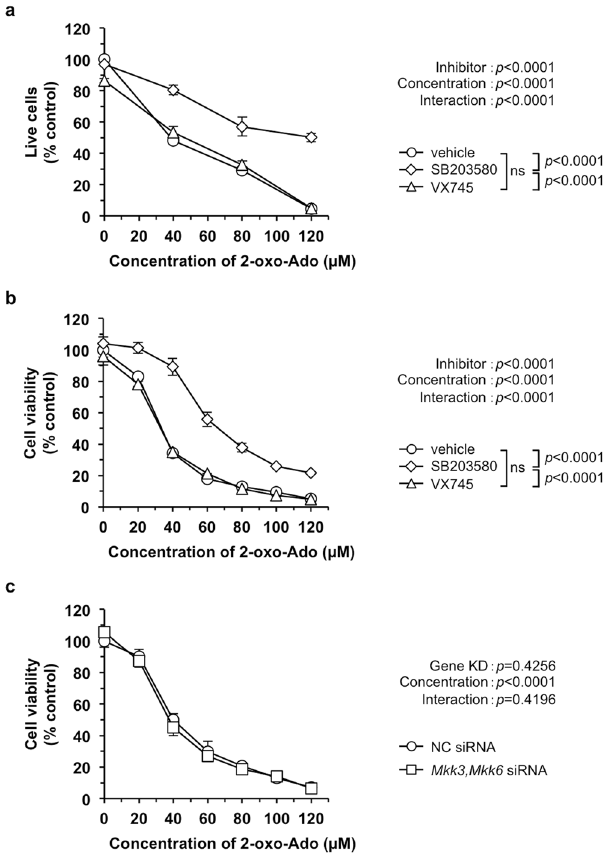
Figure 5. SB203580 blocks 2-oxo-Ado-induced cell death but not via inhibition of the p38 MAPK pathway. ( a , b ) The number of live T9 cells was determined by trypan blue exclusion ( a ), and cell viability of T9 cells was determined by WST-8 assays ( b ). Cells were incubated in the presence of various concentrations of 2-oxo-Ado with or without the indicated inhibitors for 24 h. SB203580 and VX745, 10 µ M. Vehicle control, 0.1% DMSO. Values (% control) of the number of live cells relative to that of the control in the absence of 2-oxo-Ado are shown as the mean ± SD of three experiments. ( c ) Cell viability of T9 cells was determined by WST-8 assays. Cells were treated with target siRNAs or NC siRNA as the control for 48 h and then incubated with various concentrations of 2-oxo-Ado for 24 h. Values (% control) of cell viability relative to that of the control in the absence of 2-oxo-Ado are shown as the mean ± SD of three experiments. Results were statistically analysed by two-way ANOVA ( a – c ) and post-hoc Tukey’s HSD test among different inhibitor conditions ( a , b